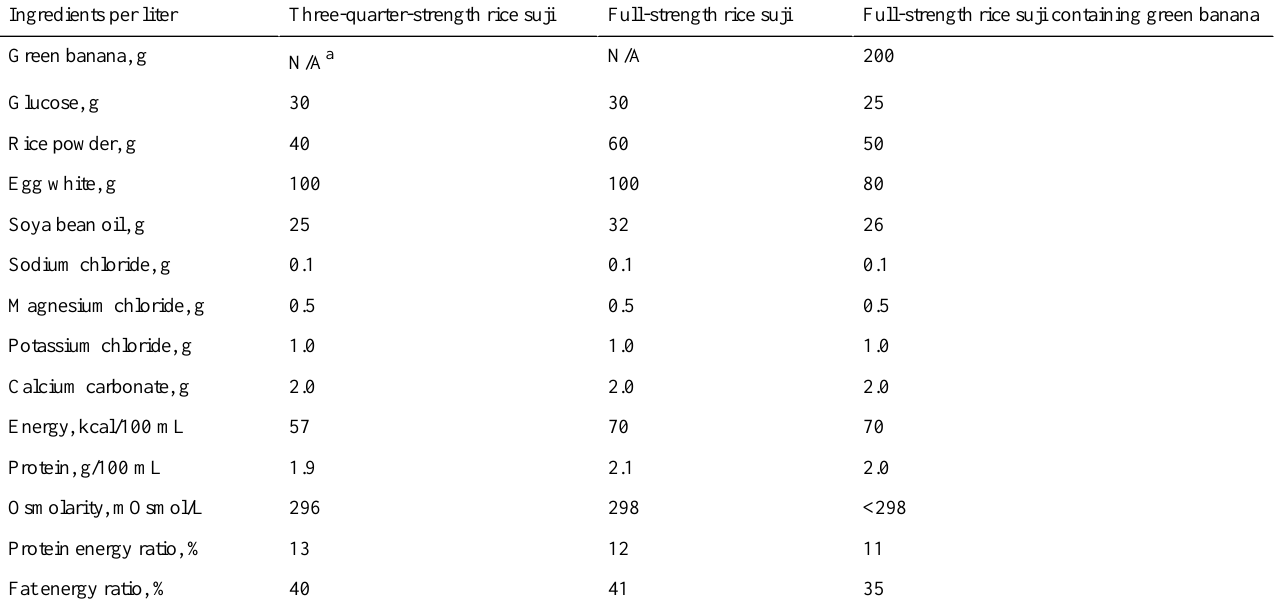
Table 3. Proposed dietary composition for this randomized controlled